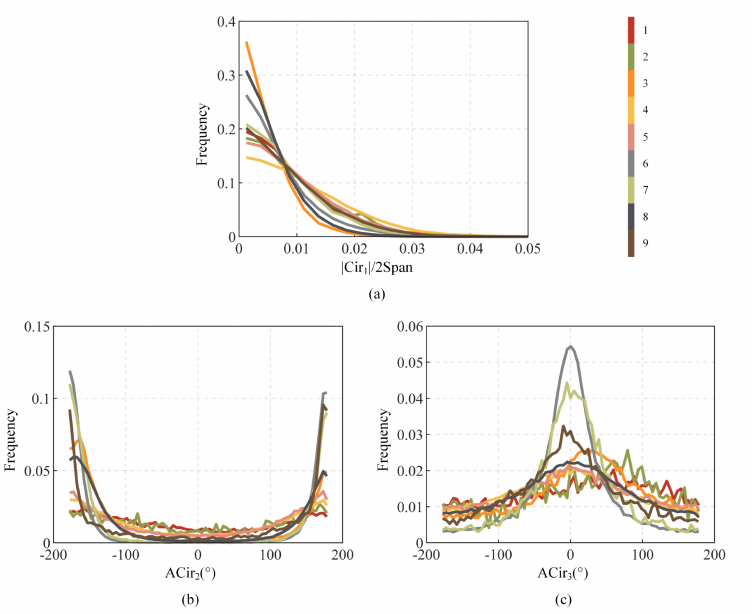
| /2Span, ( b ) ACir 2 , and ( c ) ACir 3 of volume-dominated targets in 1